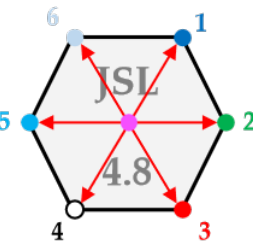
Figure 5. The labeling order of key-points. Table 1. Smart phone camera specifications.